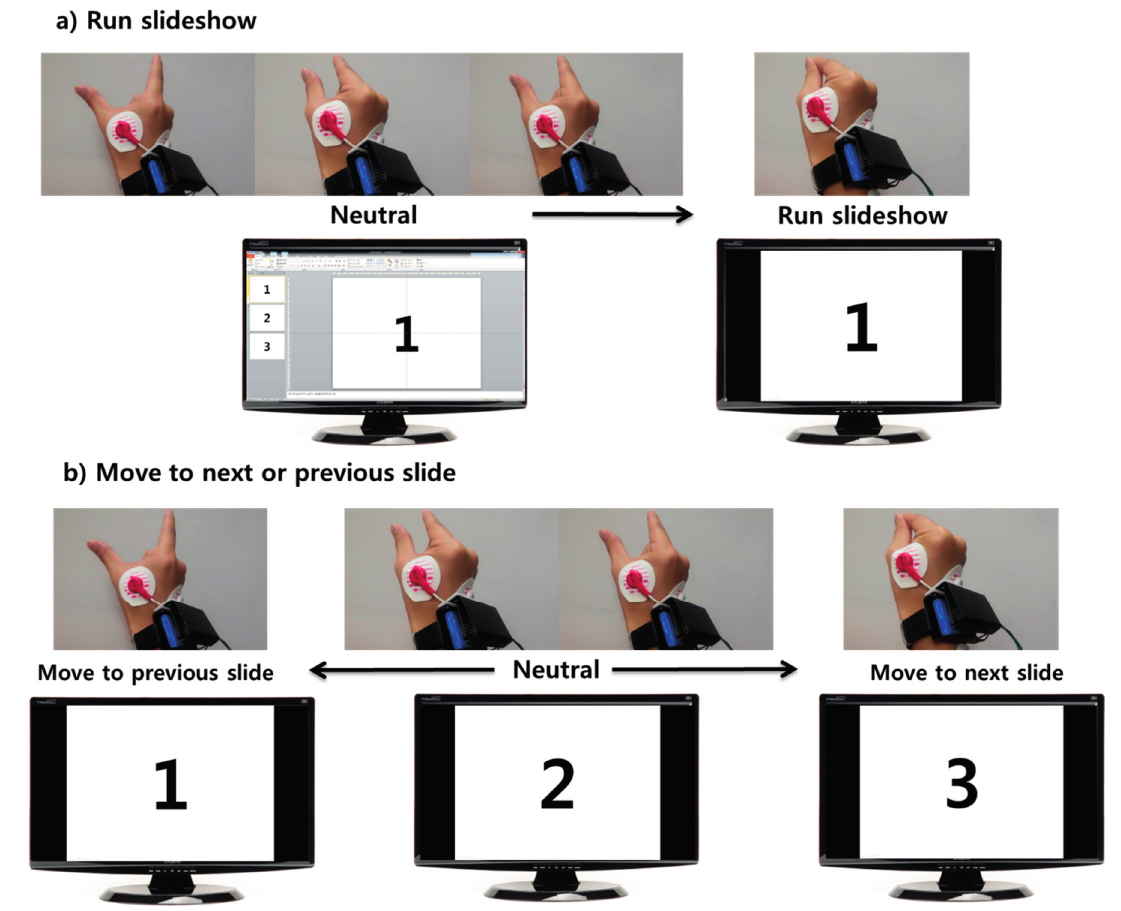
Figure 7. Snapshots of the application to control Powerpoint 2010 based on the pinch-to-zoom recognition system. ( a ) Scenario to run a slideshow. In this case, our system transforms the result of classifier, 0 cm into the command, “run slideshow” and the others (4 cm, 8 cm and 12 cm) into neutral commands; ( b ) Scenario to move slide. In this case, our system transforms the 12 cm result of the classifier into the command, “move to previous slide”, 0 cm into “move to next slide”, and both 4 cm and 8 cm into